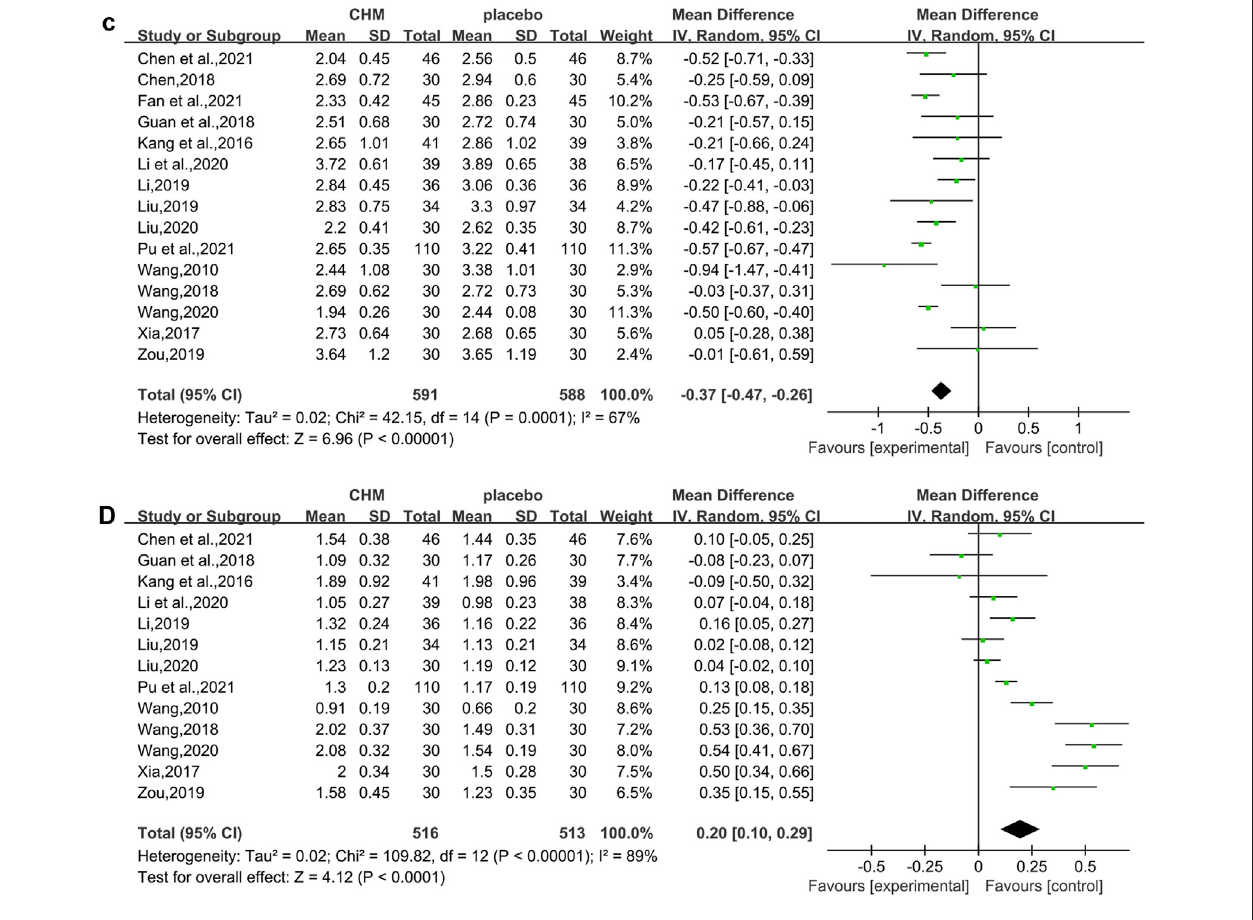
Frontiers in Pharmacology |